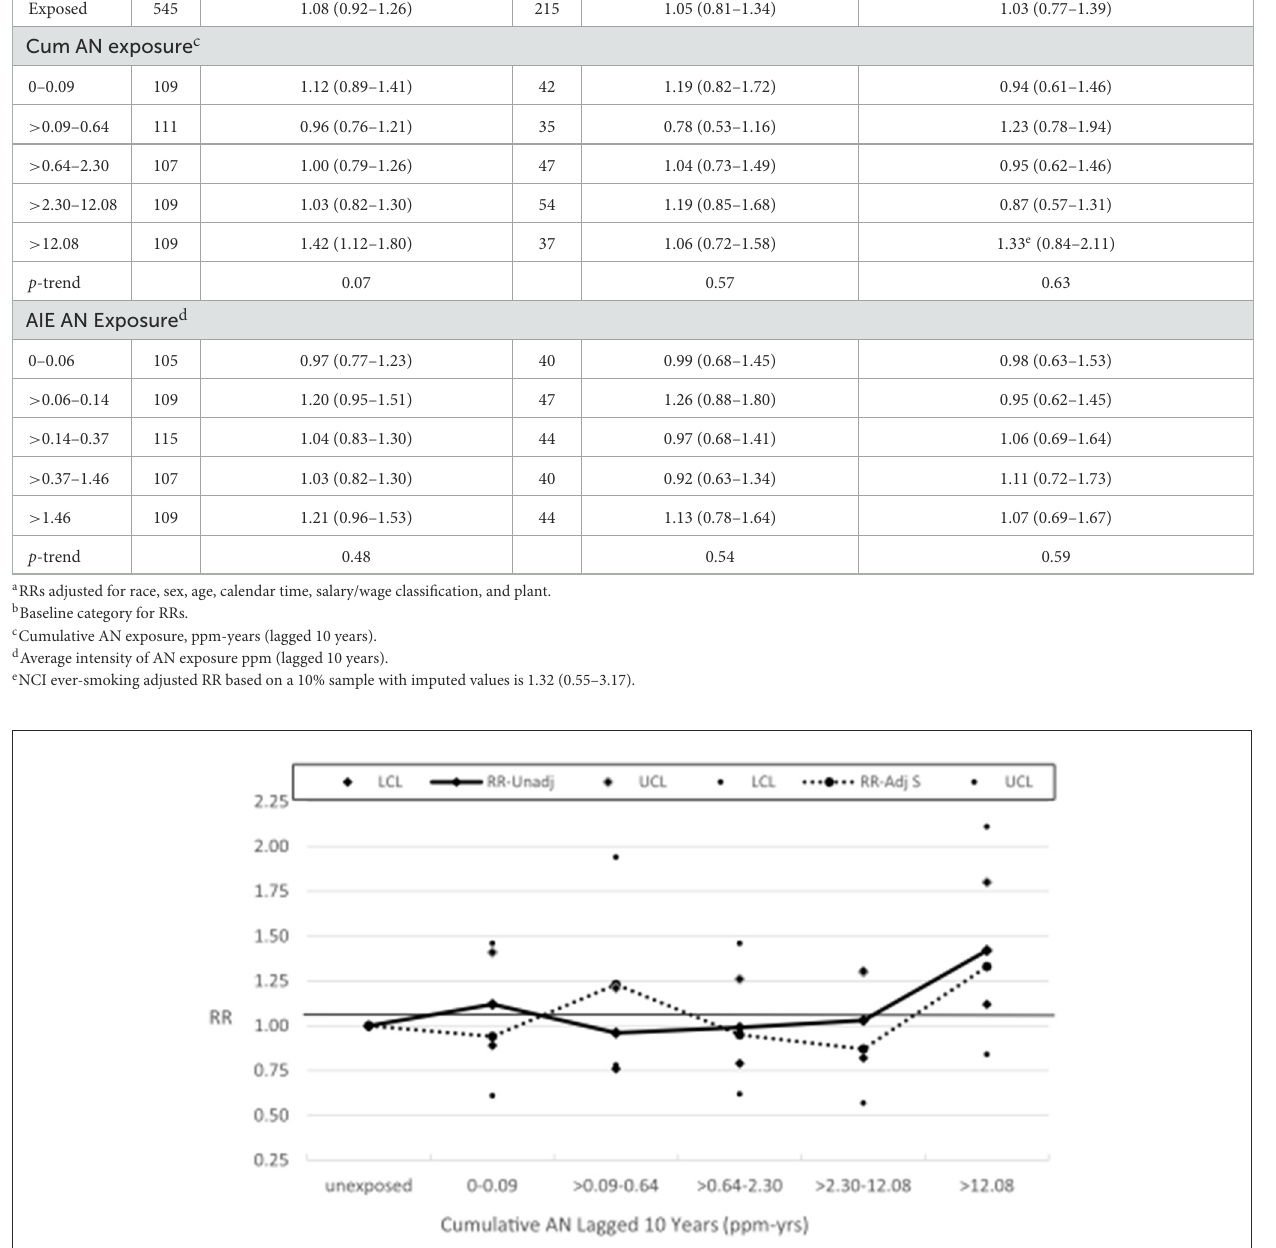
of exposure–response relationship (unadjusted trend p = 0.01 vs. adjusted trend p =